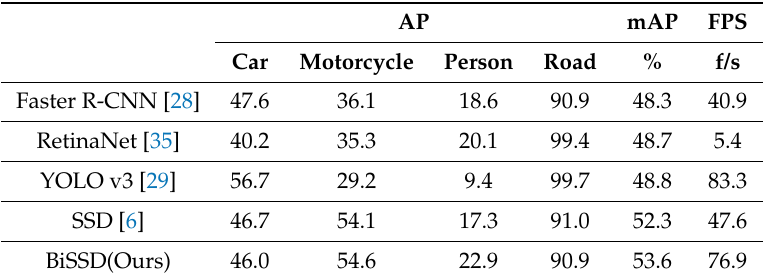
Table 1. Experimental results of each model on the large data set.